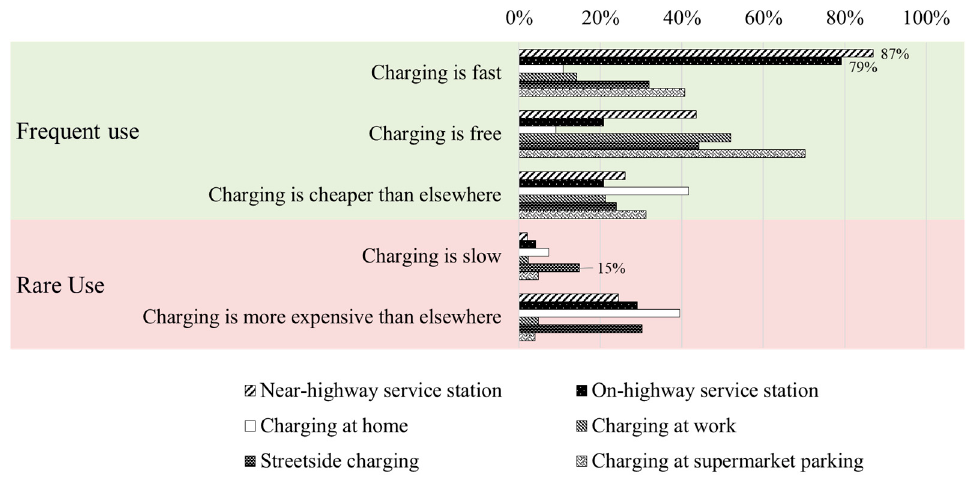
Figure 9. Reasons for the frequent and rare use of charging infrastructure (n = 403; own diagram based on [9]).